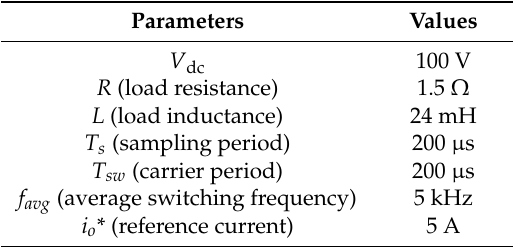
Table 2. Parameter values for simulation and experiment.